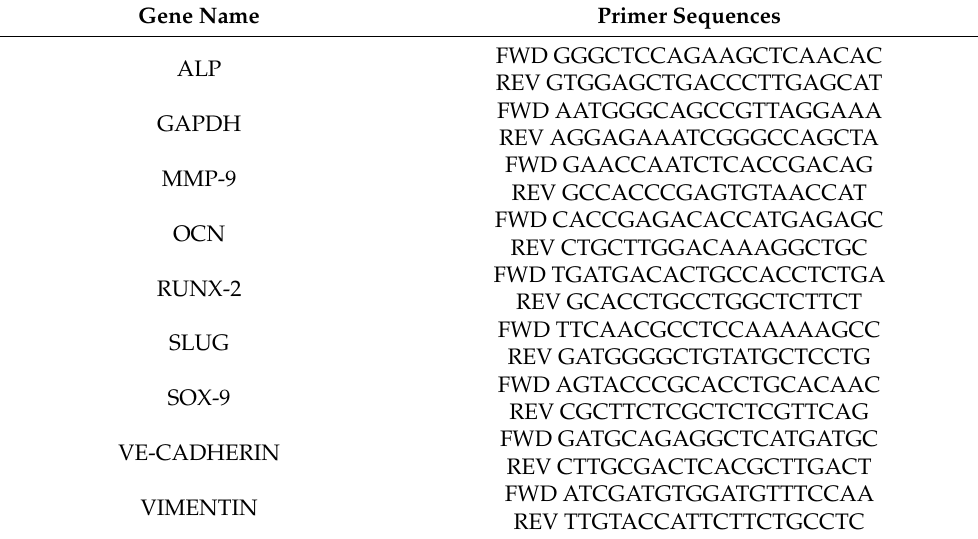
Table 1. List of primer sequences used for Real-Time